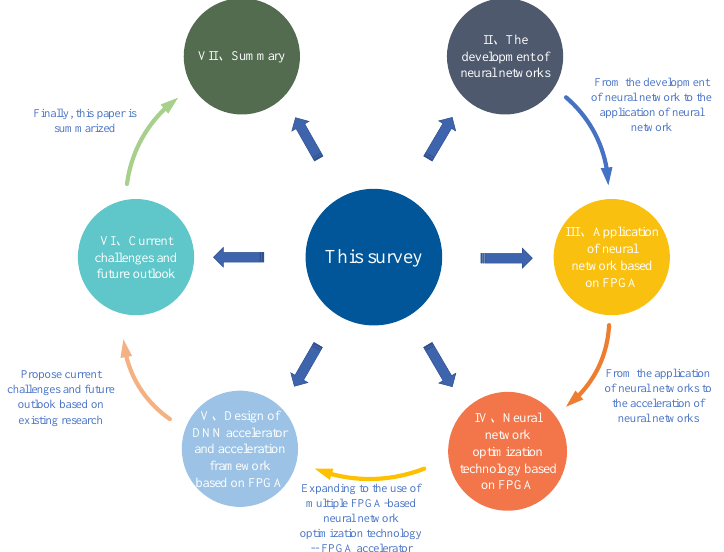
Figure 1. The structural layout of this paper.